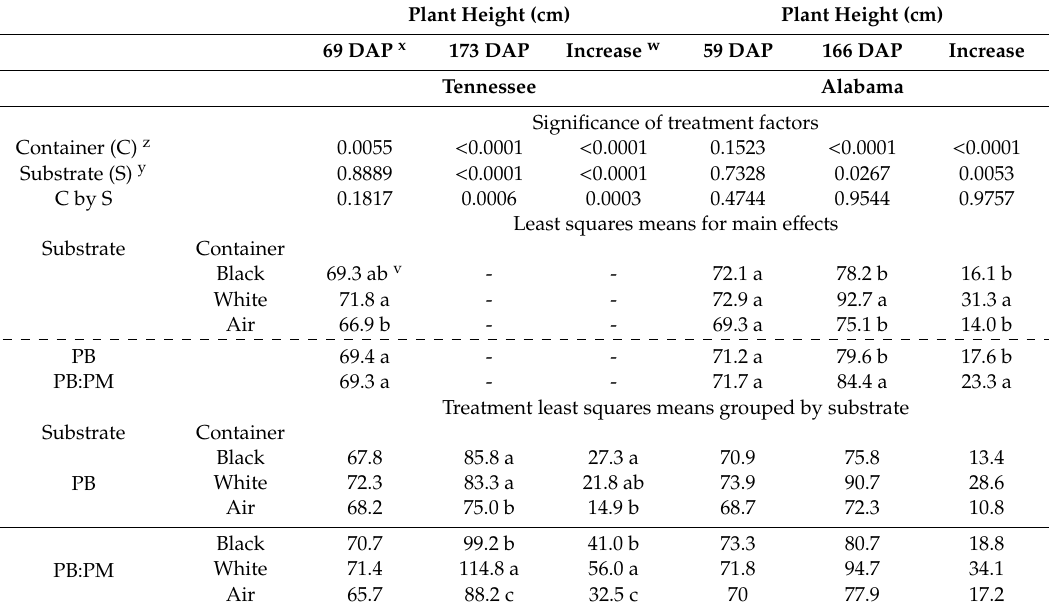
Table 1. Plant height and height increase (n = 12) of ‘Green Giant’ arborvitae grown in di ff erent types of containers and substrates in Tennessee and Alabama. Plant Height (cm) Plant Height (cm) 69 DAP